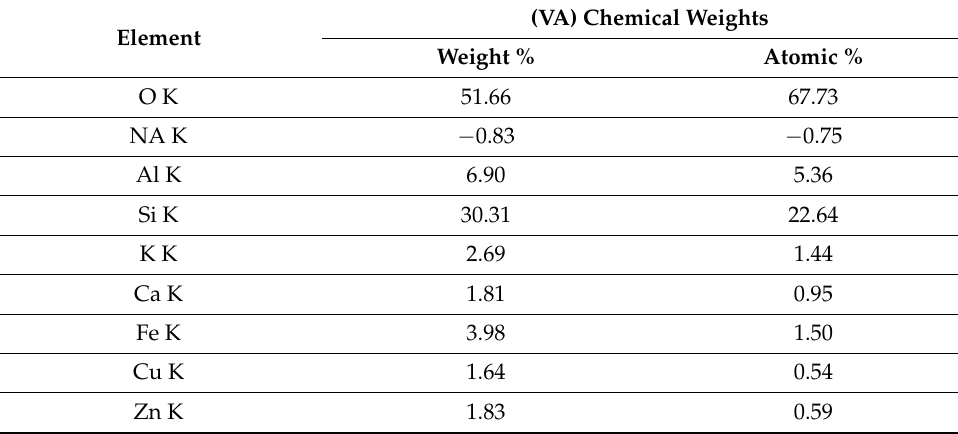
Table 3. EDX analysis results of volcanic ash.